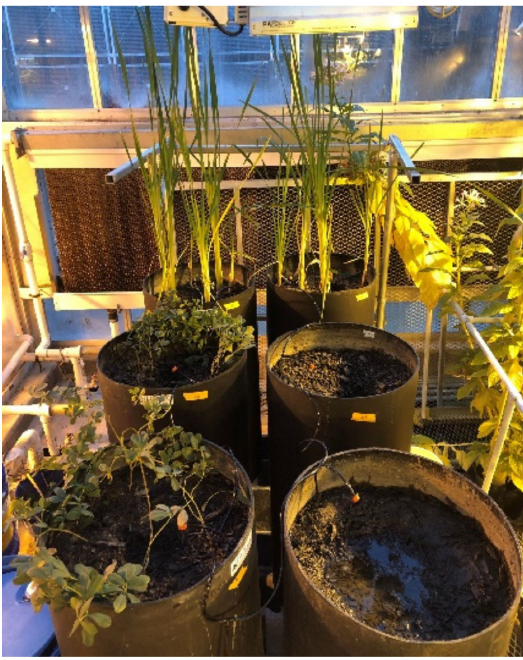
Figure 4. Six soil columns in laboratory.